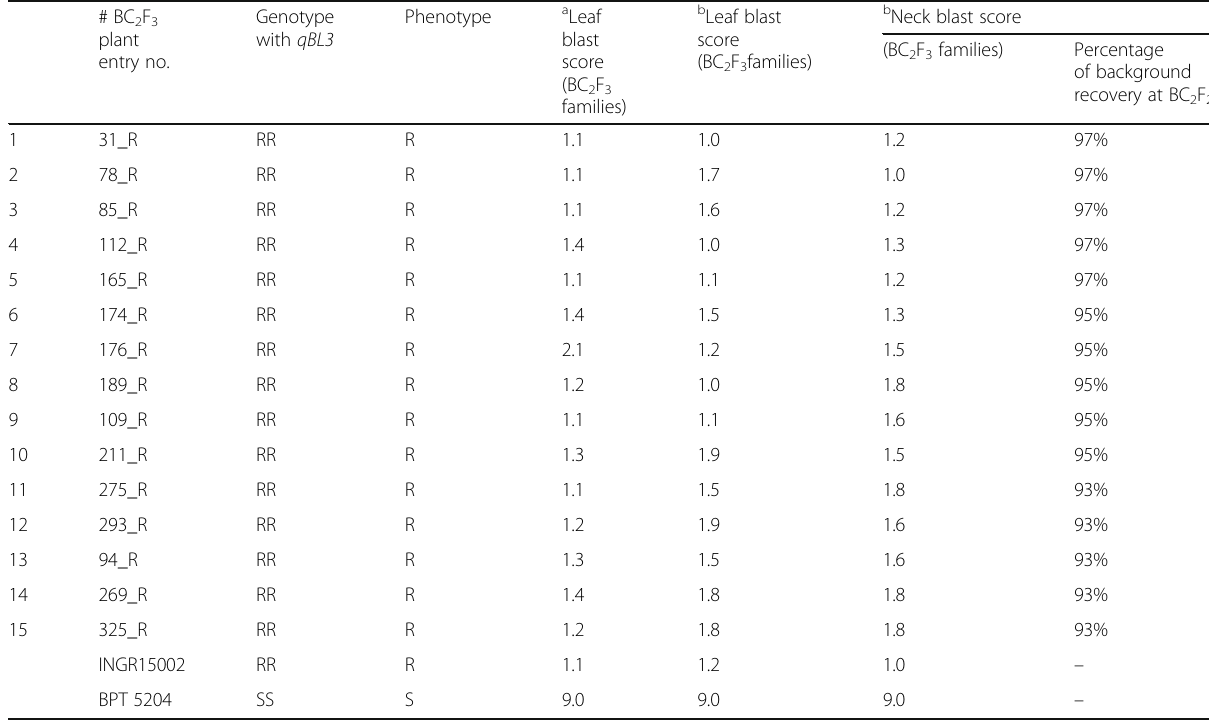
Table 2 Phenotyping and genotyping of qBL3 BC 2 F 3 lines # BC 2 F 3 plant entry